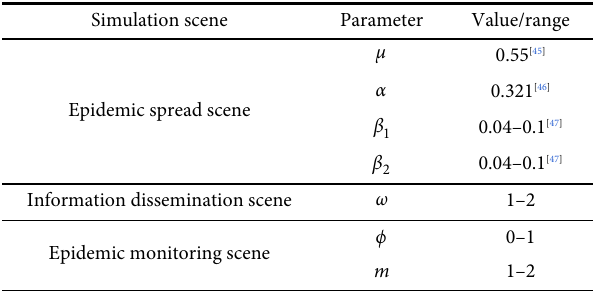
Table 1 Parameter values for the